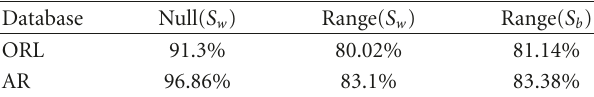
Table 3: Recognition accuracy of BEDFE in di ff erent subspaces.